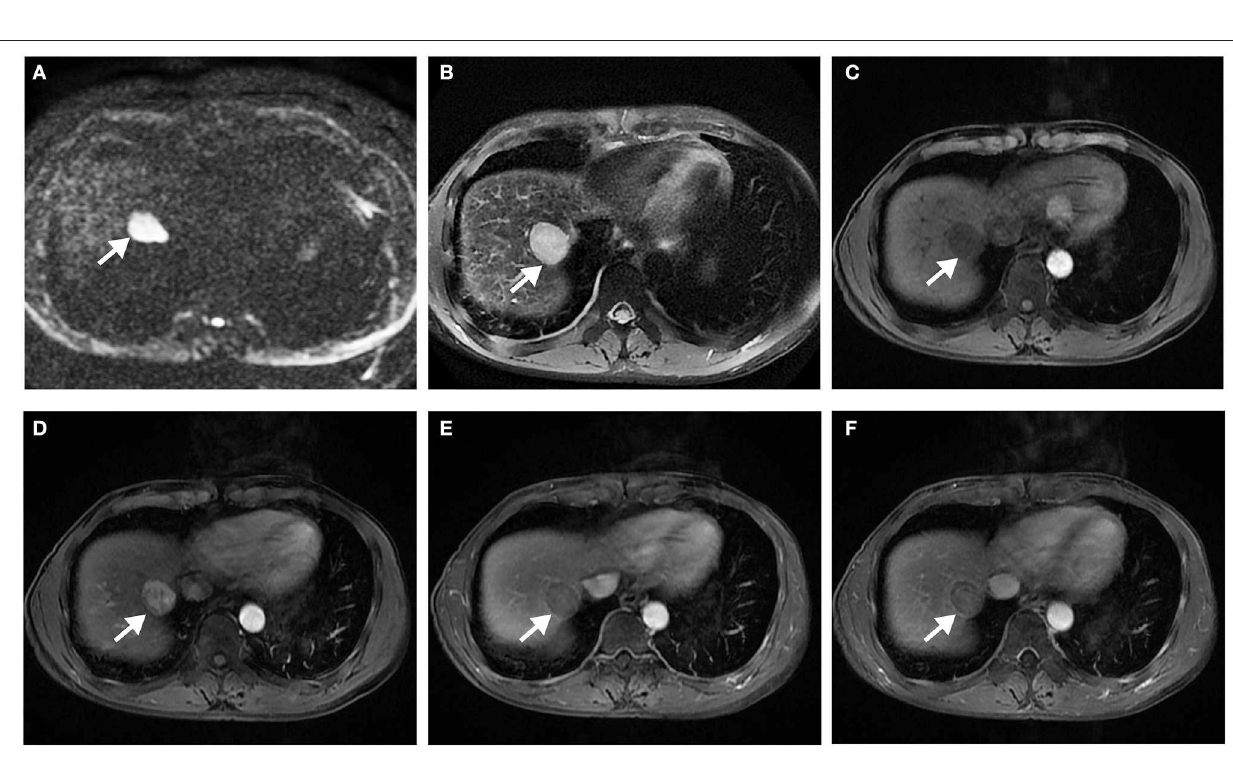
Frontiers in Oncology | www.frontiersin.org